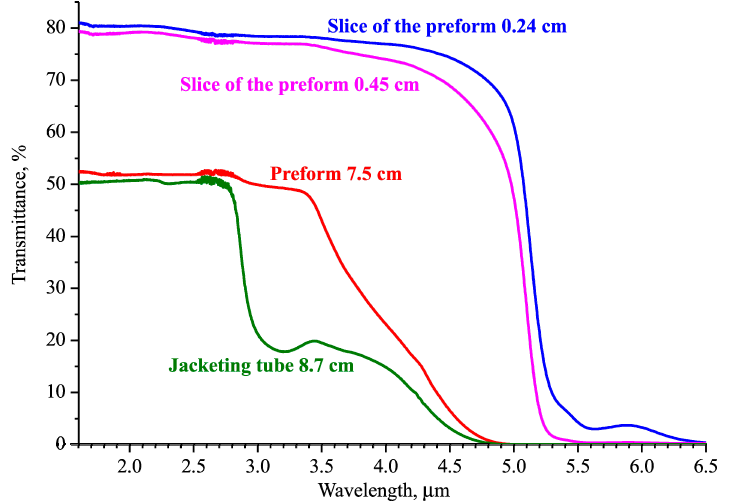
Figure 2. IR transmission spectra of the preform ( L = 7.5 cm), jacketing tube ( L = 8.7 cm), and two slices of the preform ( L = 0.24 cm and L = 0.45 cm).